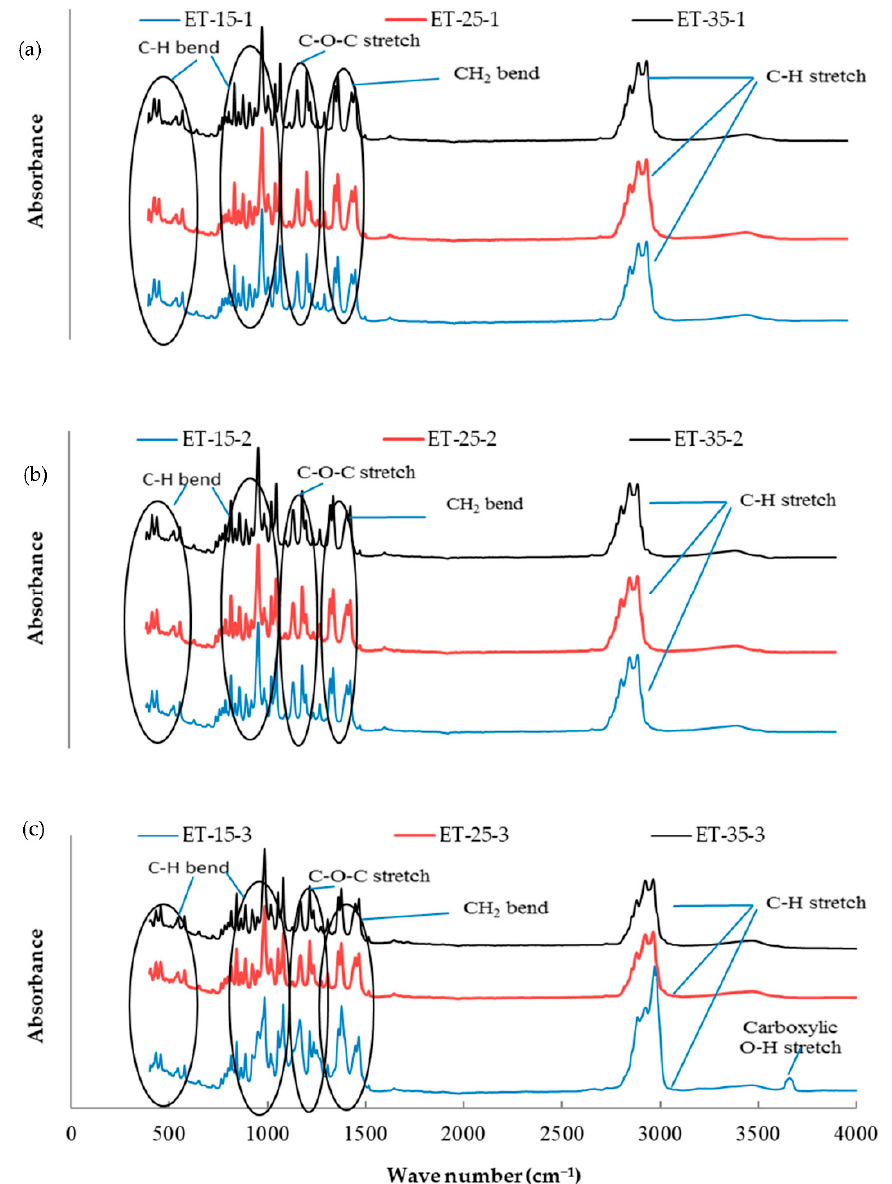
Figure 5. Fourier-transform infrared spectroscopy (FTIR) analysis for the essential oil combination of eucalyptus + tea tree (ET) at different temperatures (15, 25, and 35 °C) and different times of storage (1–3 months) (different colors refer to different temperature per subfigure). ( a ) This figure refer to the effect of different temperature at 15, 25, and 35 °C on the combination of ET stored for one month; ( b ) the second subfigure refer to different temperature at 15, 25, and 35 °C on the combination of ET stored for two months; ( c ) the third subfigure refer to different temperature at 15, 25, and 35 °C on the combination of ET stored for three months.